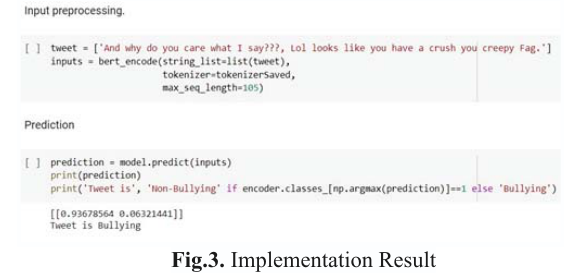
Fig.3. Implementation Result